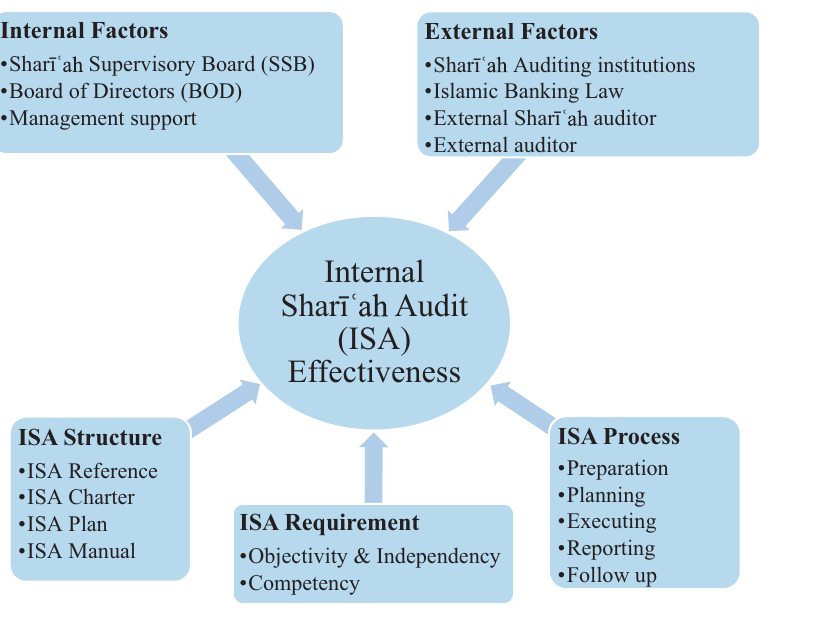
Figure 1. Proposed